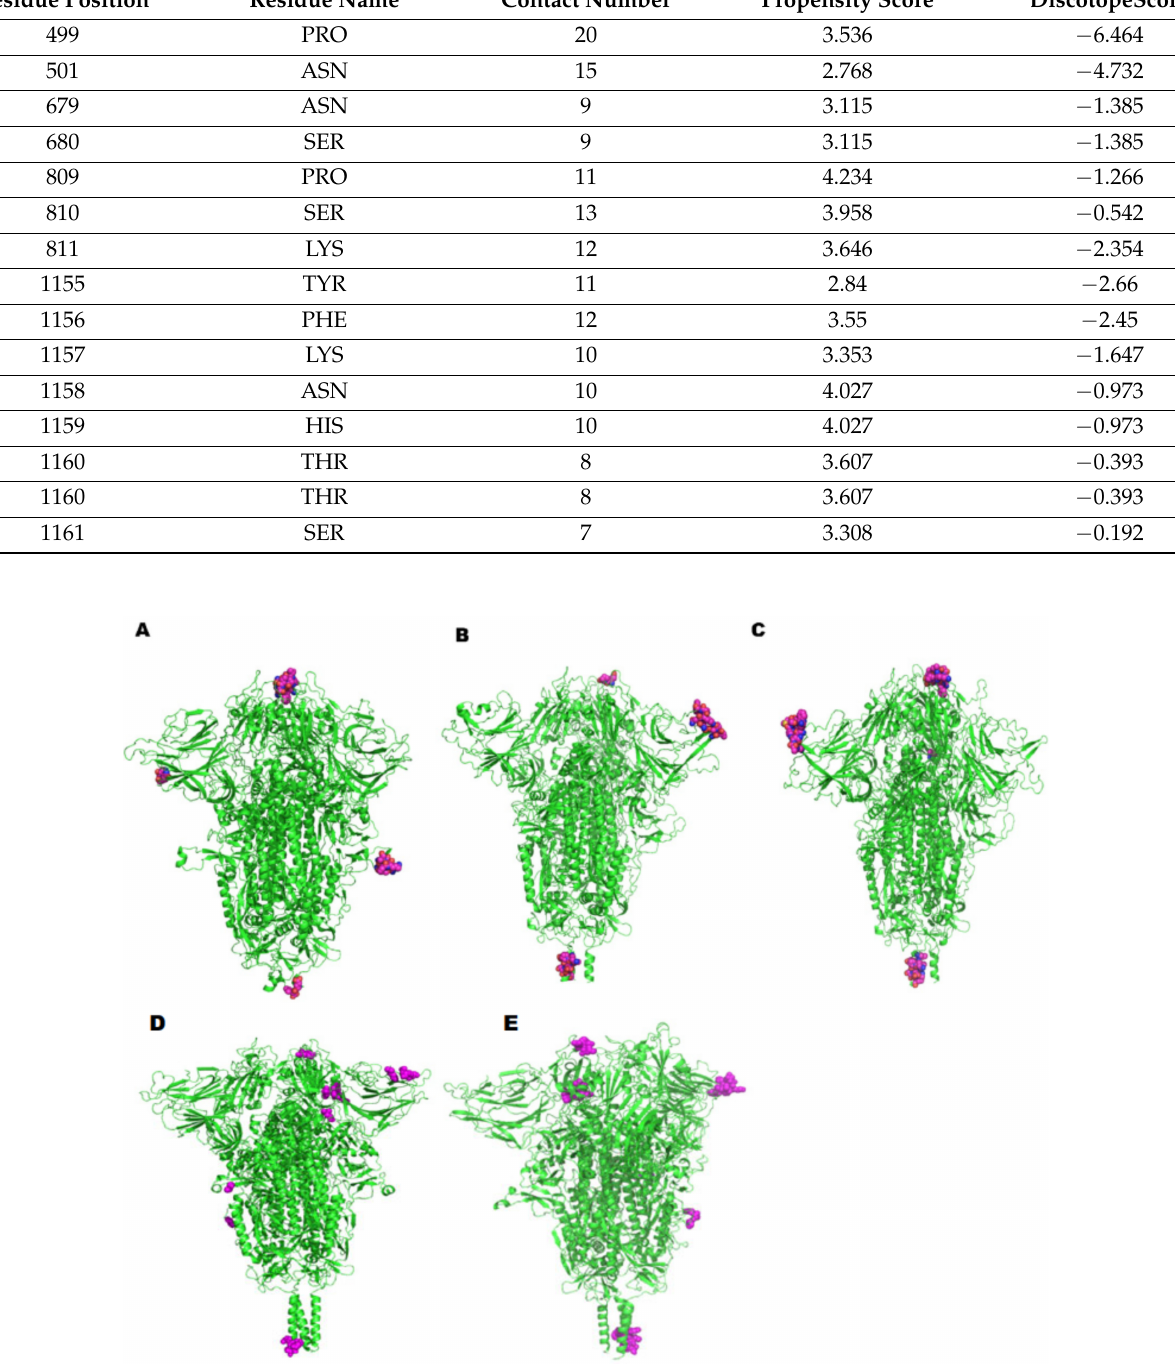
Figure 3. Representations of potential discontinuous B-cell epitopic regions mapped onto the spike protein of the SARS- CoV-2 variants: ( A ) Wuhan, ( B ) England, ( C ) USA, ( D ) India, and ( E ) South Africahighlighted as